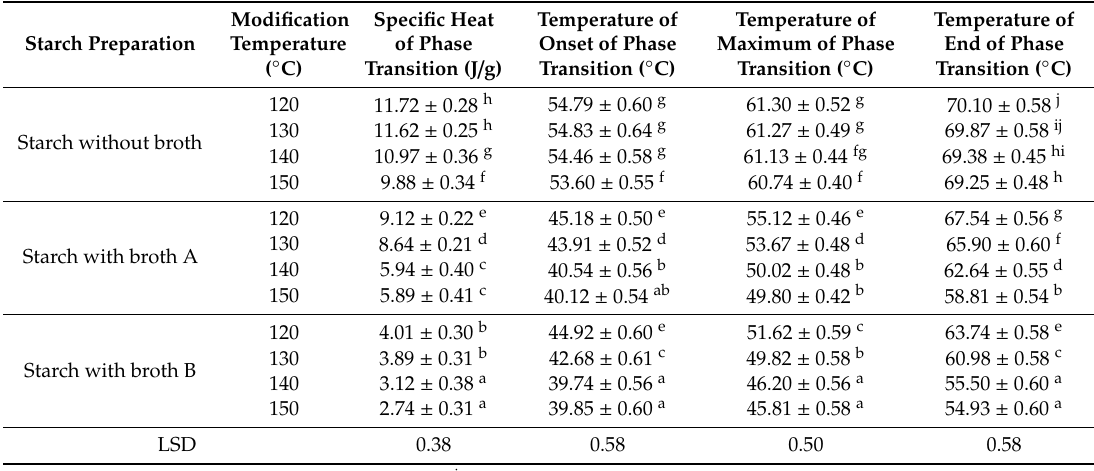
Table 2. Thermal analysis of starch esters as a ff ected by modification